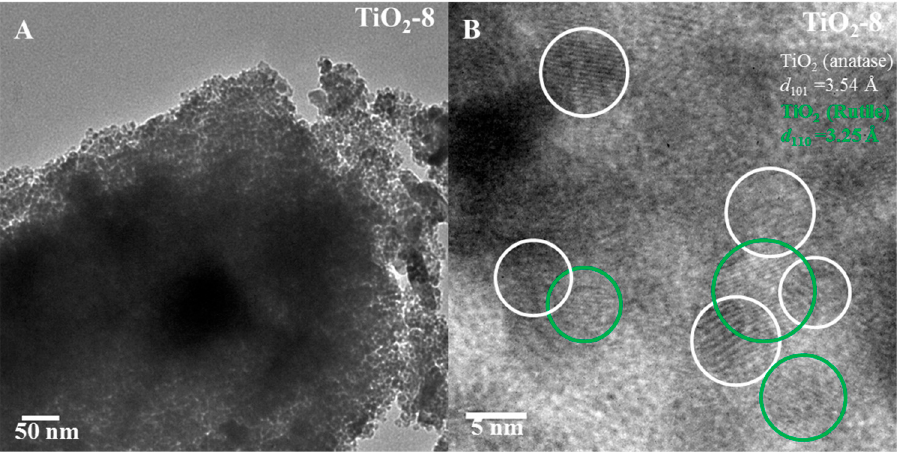
Figure 6. TEM images of TiO 2 -8 (( A ) low magnification and ( B ) high magnification) nanocasted titania mesoporous material. The green and white circles denote rutile and anatase phase respectively